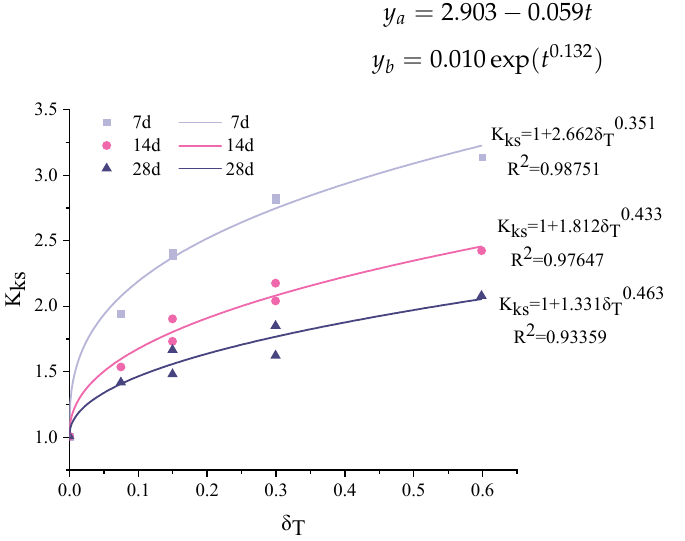
Figure 4. Relationship between stress influence coefficient and flexural tensile stress level.